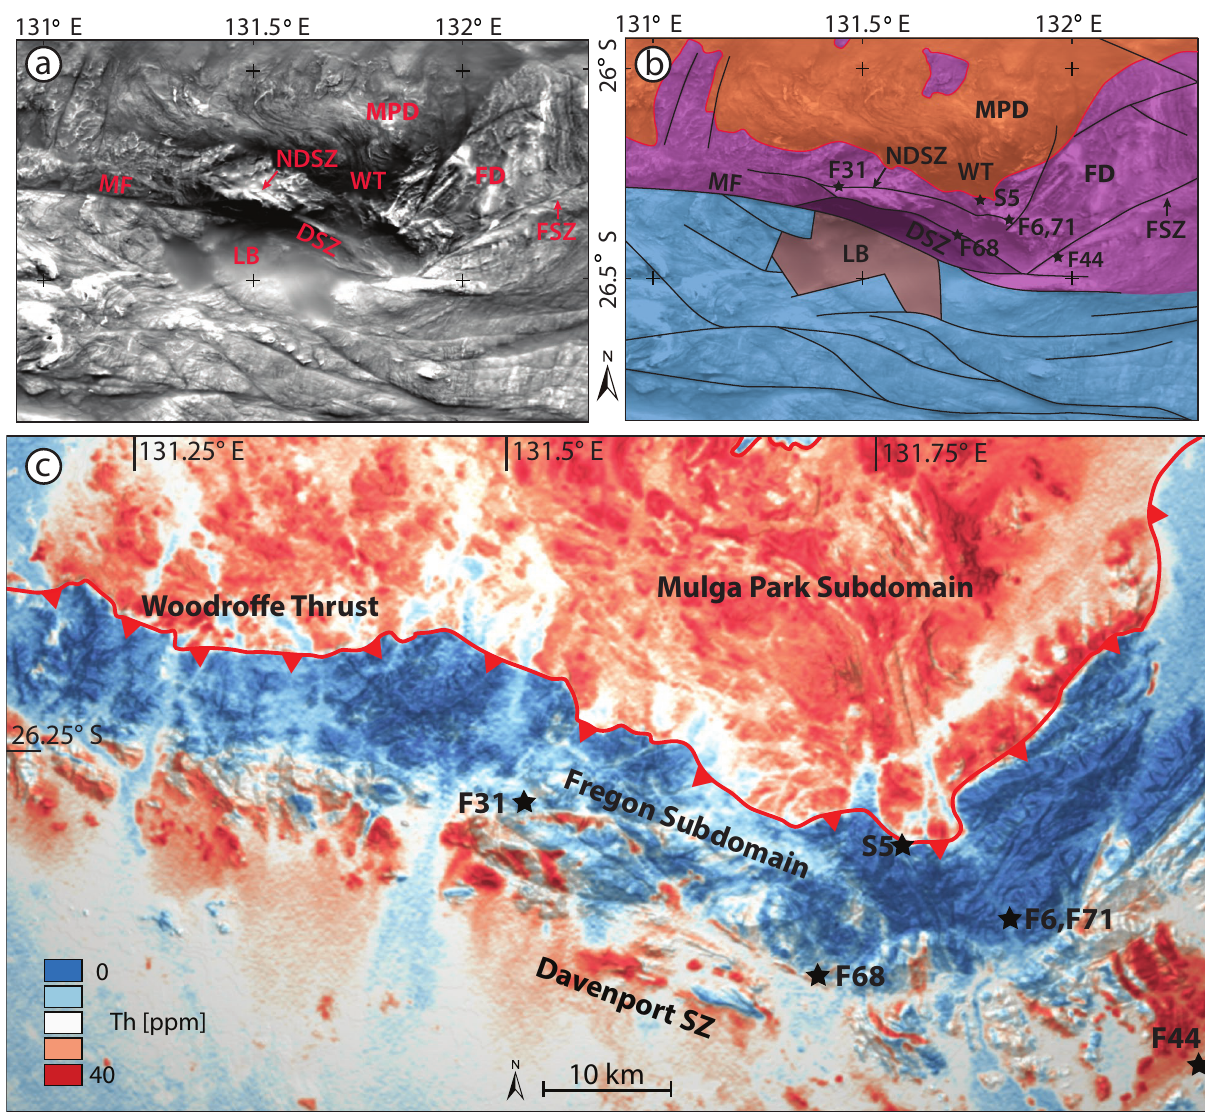
Figure 2. (a) Total magnetic intensity map (Milligan and Nakamura, 2015) and interpreted structures. Most fault zones appear as dark lines with a marked contrast; lithological layering is visible in the Mulga Park Subdomain (MPD), whereas the sediments of the Levenger Basin (LB) appear blurred. (b) Interpretation of the tectonic framework of the Central Musgrave Block. The Mann Fault (MF) separates units that did not experience high-grade overprint during the Petermann Orogeny in the south (blue), from the Fregon Subdomain (FD, purple) in the north. The Davenport Shear Zone (DSZ), North Davenport Shear Zone (NDSZ), and the Woodroffe Thrust (WT) were mapped by integrating the magnetic intensity map with airborne imagery and direct field observations. (c) Compilation of airborne gamma ray surveys, with the concentration of thorium shown from blue (low) to red (high). Flares of low concentration in the footwall are associated with sediments transported from the hanging wall by rivers. Pseudotachylyte sample locations discussed in the text are indicated as black stars. Dataset SA_RAD_TH, Geological Survey of South Australia (2011); grey levels from hill shade. For a simplified geological map covering the same area, and an interpreted synthetic NS cross section, see Wex et al.